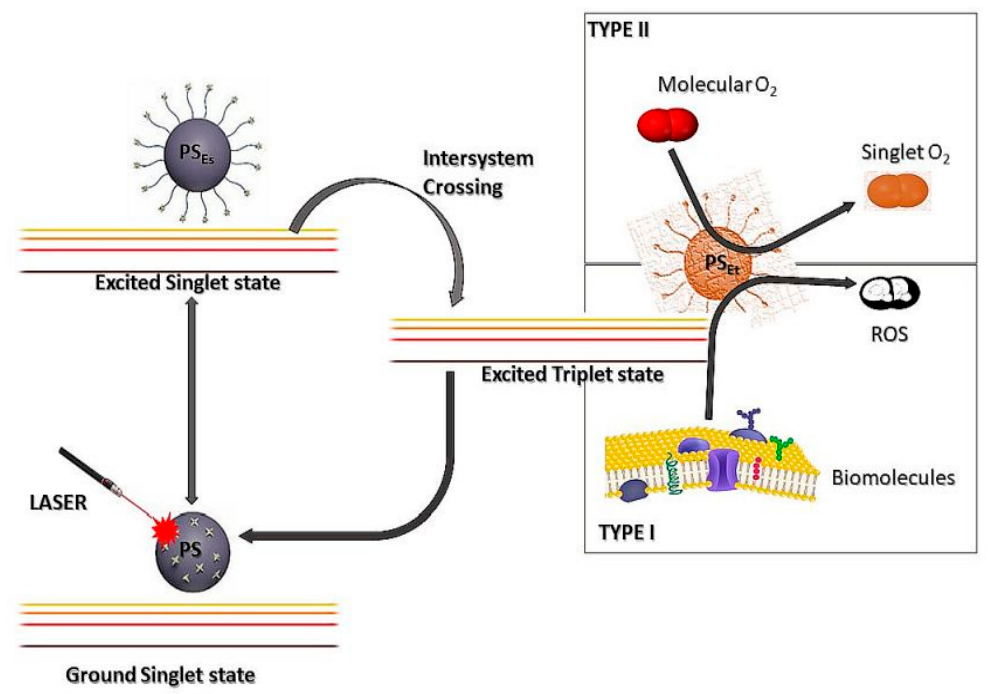
Figure 2. A schematic Jablonski diagram indicating the type I and type II reactions that cause cytotoxicity after activation of the photosensitiser (PS) with light of a specific wavelength. Photosensitisers that are triggered with wavelengths near the tissue absorption range (red region) are ideal for therapeutic purposes. It is vital for PSs to retain a high triplet quantum yield for ROS synthesis upon irradiation [21]. A number of PSs have been observed for application in the PDT of most cancers, including breast cancer. Different PSs have been indicated for successful cell death induction in a variety of different cancers (Table 2). Among the PSs, Hypericin is one of the naturally occurring PSs that have been used in PDT.